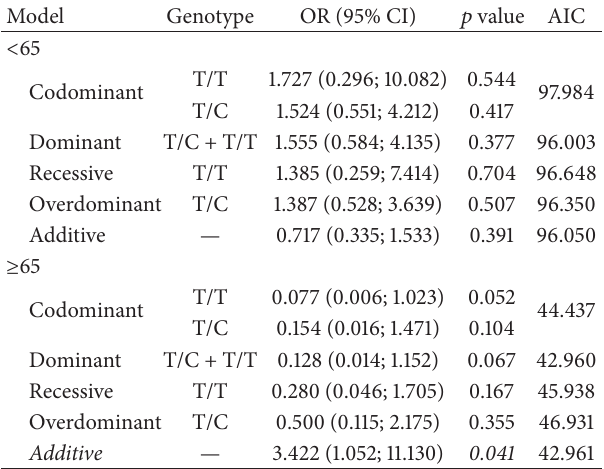
Table 9: Binomial logistic regression analysis of the CYP4F2 (1347C > T; V433M) rs2108622 in the males with early AMD and in the control group by age.